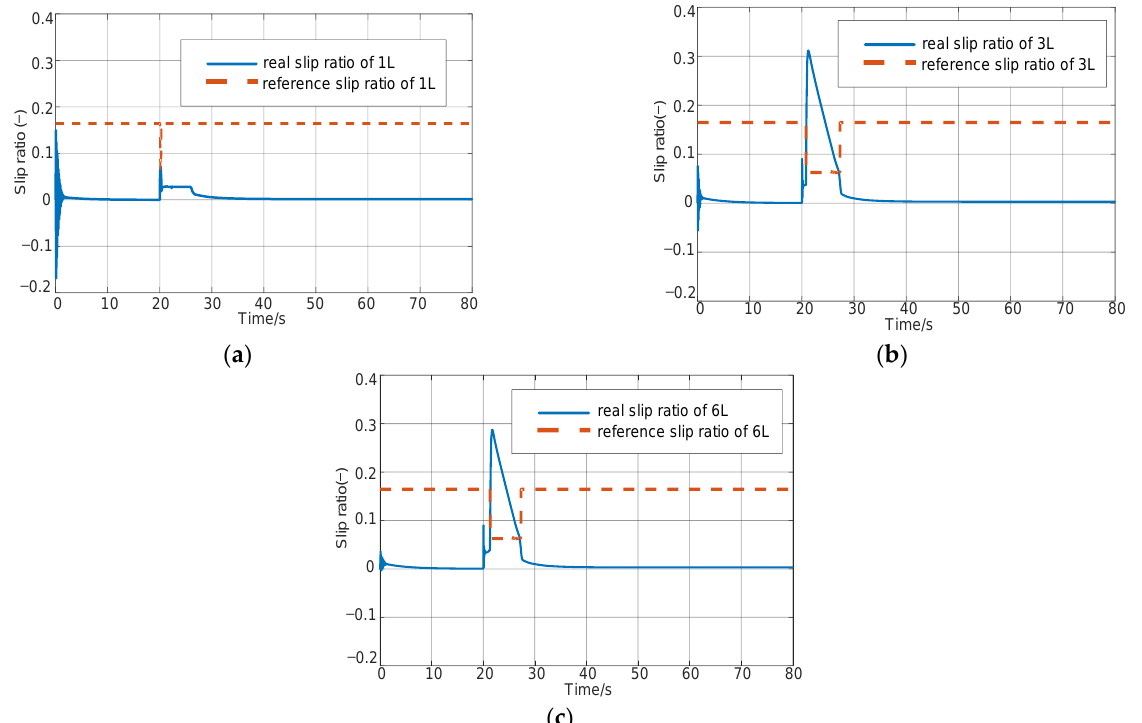
Figure 8. Slip ratio controlled by the SMC method on the changed road surface: ( a ) left wheel of the 1st axle (1L); ( b ) left wheel of the 3rd axle (3L); ( c ) left wheel of the 6th axle (6L).